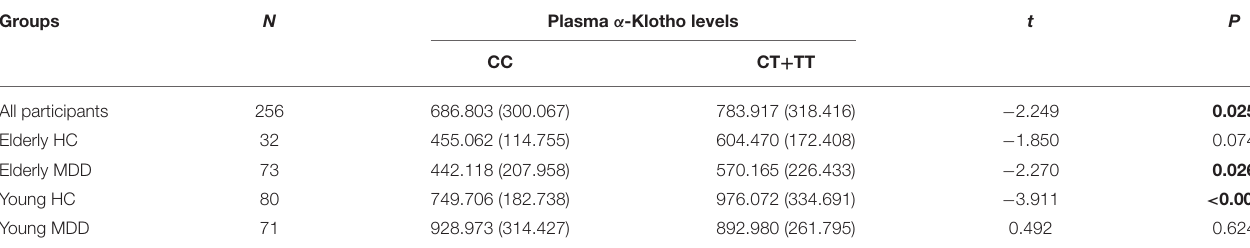
TABLE 3 | Plasma α -Klotho levels (pg/ml) according to the distribution of rs9315202 dominant model ( mean ± SD ). Groups